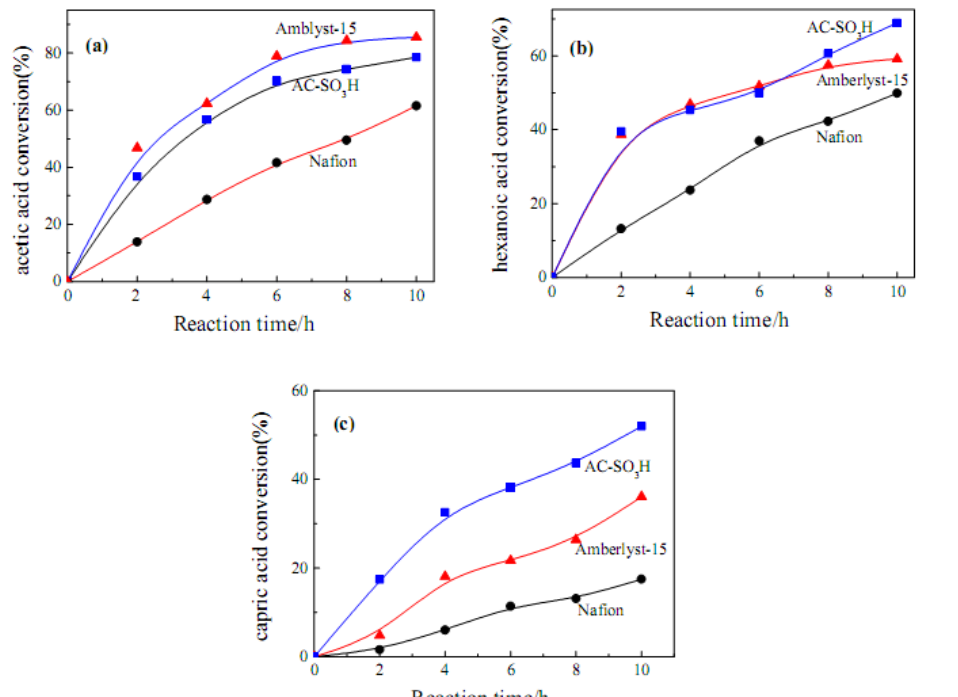
Figure 5. Acid catalyzed esterification of several aliphatic acids with ethanol: (a) acetic acid, (b) hexanoic acid, and (c) decanoic